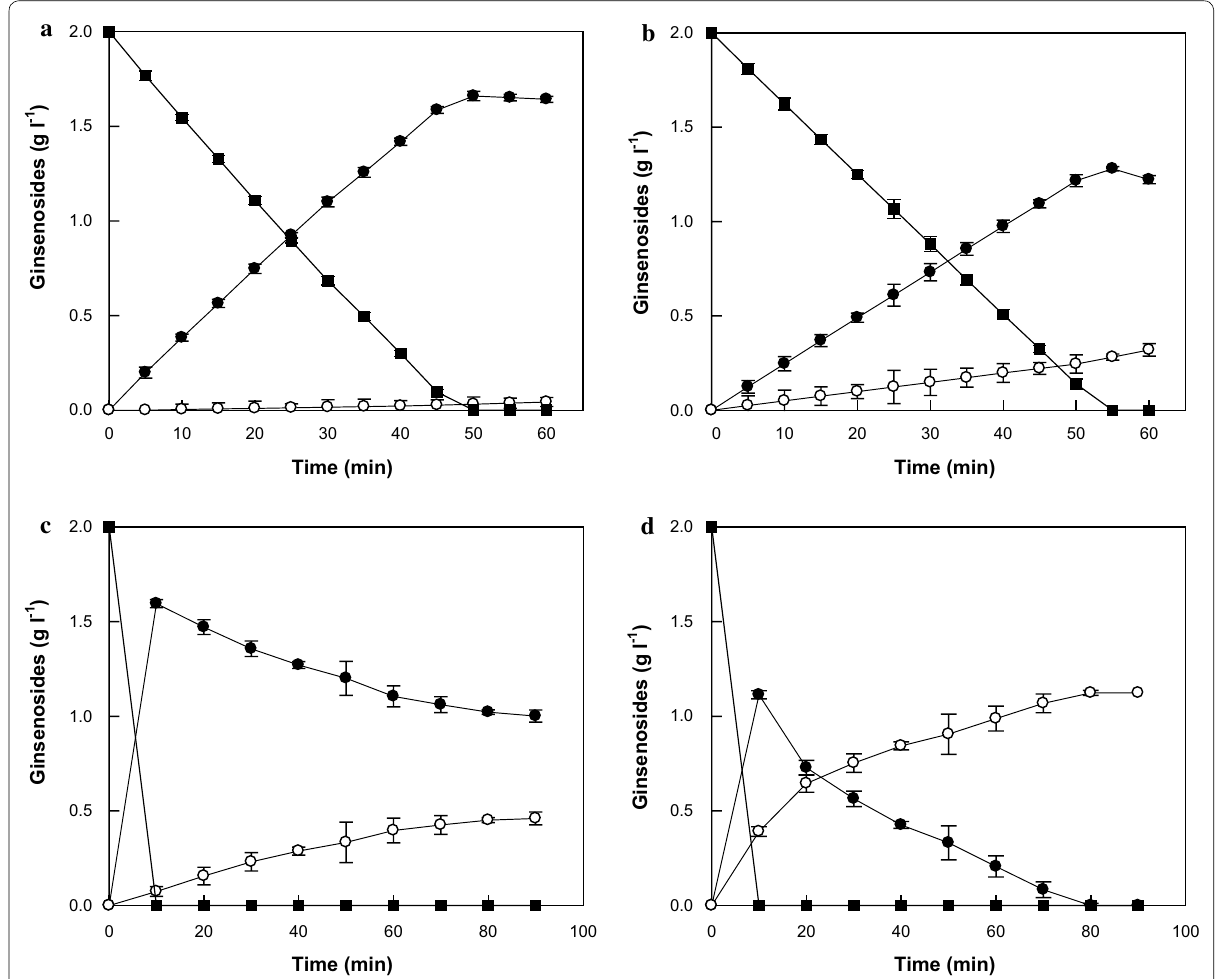
Fig. 4 Hydrolysis from ginsenoside Rb 1 to compound K via Rd and F 2 by the wild‑type and W361F‑variant SS‑BGLs. Ginsenoside F 2 was not detected in the hydrolysis reactions because of high specific activity for ginsenoside F 2 . Ginsenoside Rb 1 (closed square), Rd (closed circle), and